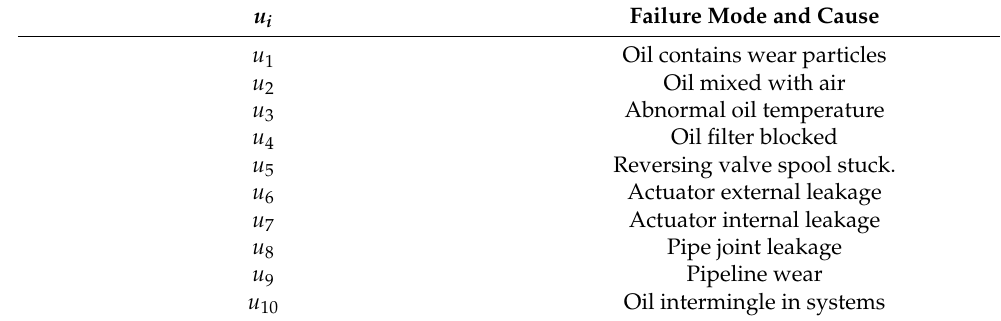
Table 3. Indicator factor set u i .